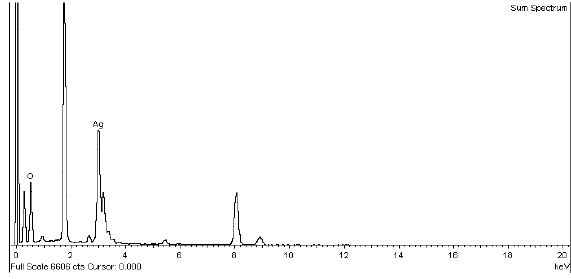
Figure 13. Nano-Ag particle energy-dispersive X-ray spectroscopy (EDS) analysis.